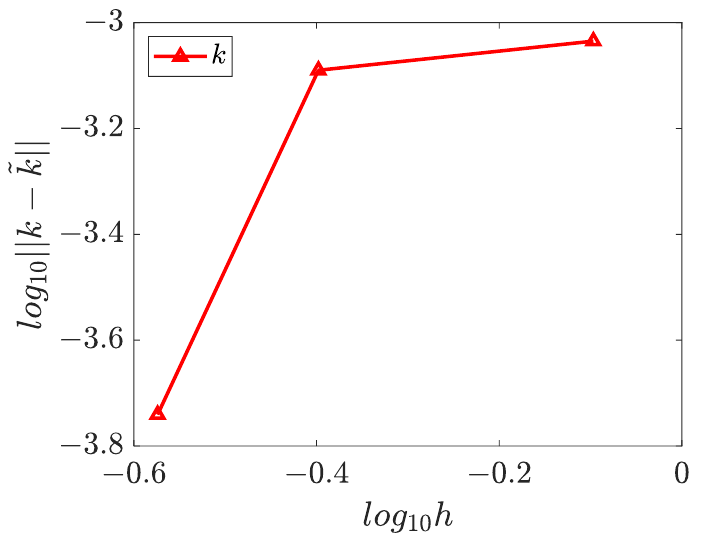
Figure 13. Convergence of wave number for the 2D constant parameter identification problem in irregular geometry.